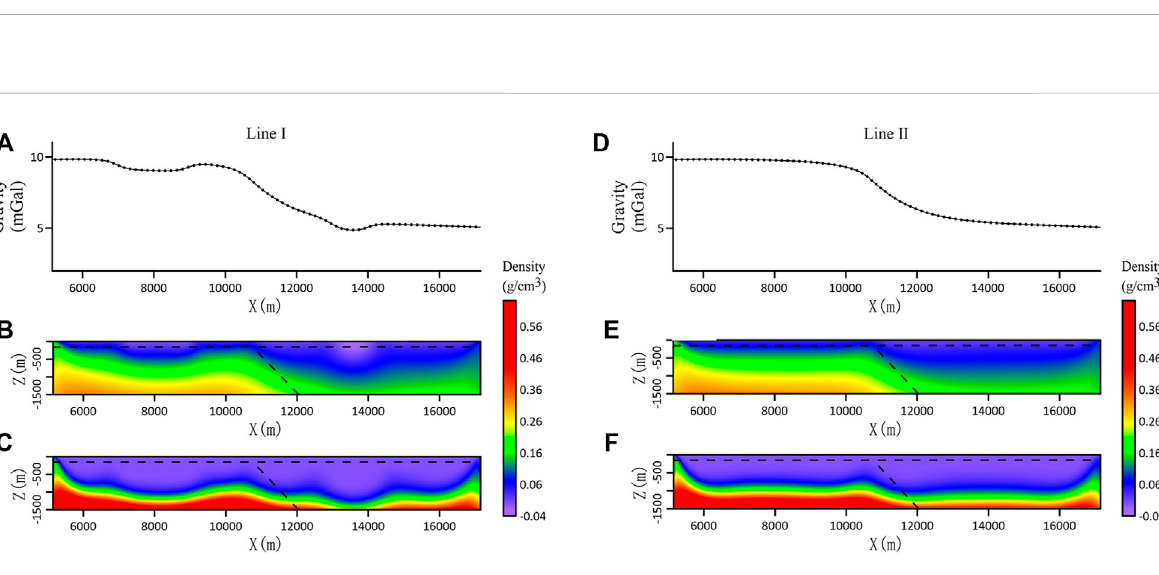
FIGURE 4 Gravity curves and inversion results pro fi les of line I and line II. (A) Gravity anomaly curve of line I. (B) Slice the inversion result of line I without focusing constraint. (C) Slicing of line I focusing inversion results. (D) Gravity anomaly curve of line II. (E) Slice the inversion result of line II without focusing constraint. (F) Slicing of II line focusing inversion